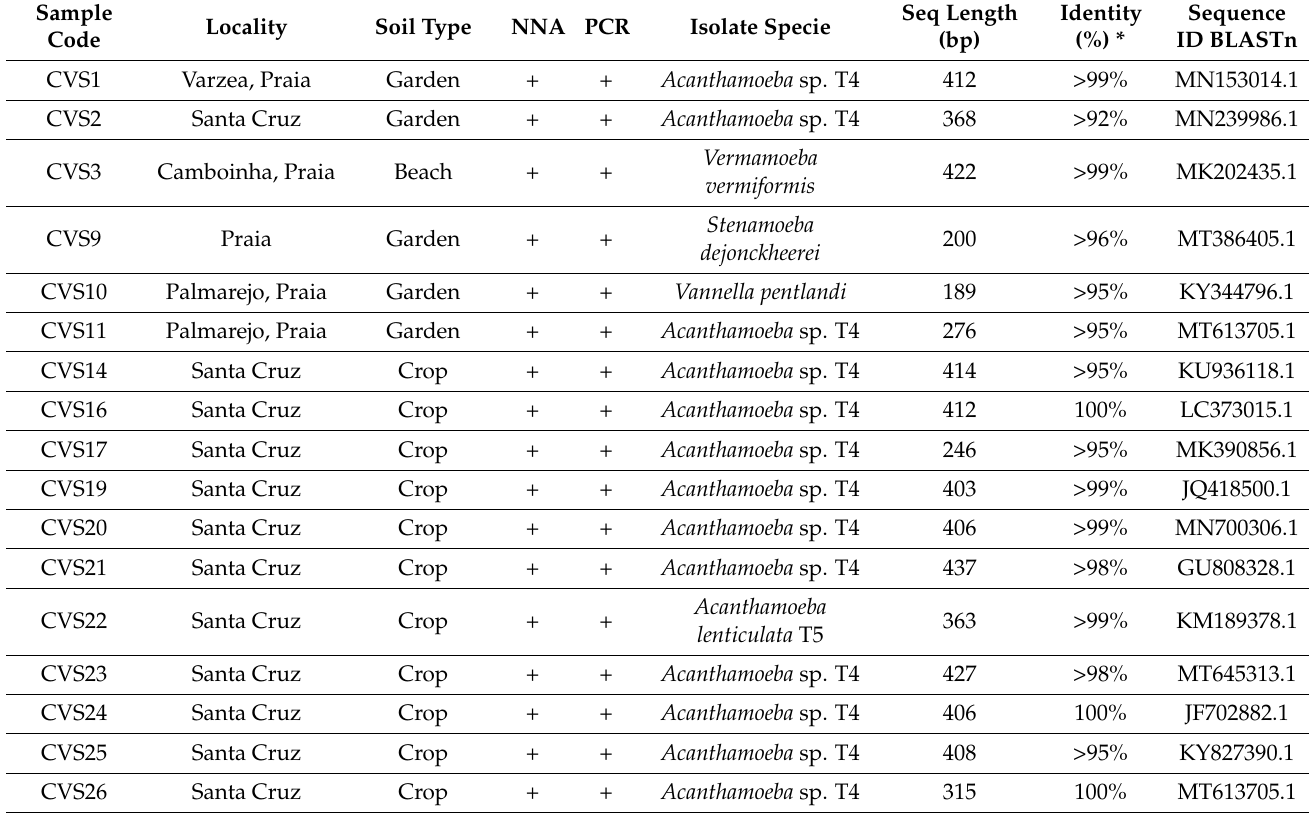
Table 1. Report of the FLA species isolated from environmental soils of Cape Verde (NNA: FLA growth in non-nutrient agar culture; PCR: FLA detection by PCR;bp: base pairs; * Homology (%) related to NCBI Data Base sequence). Sample